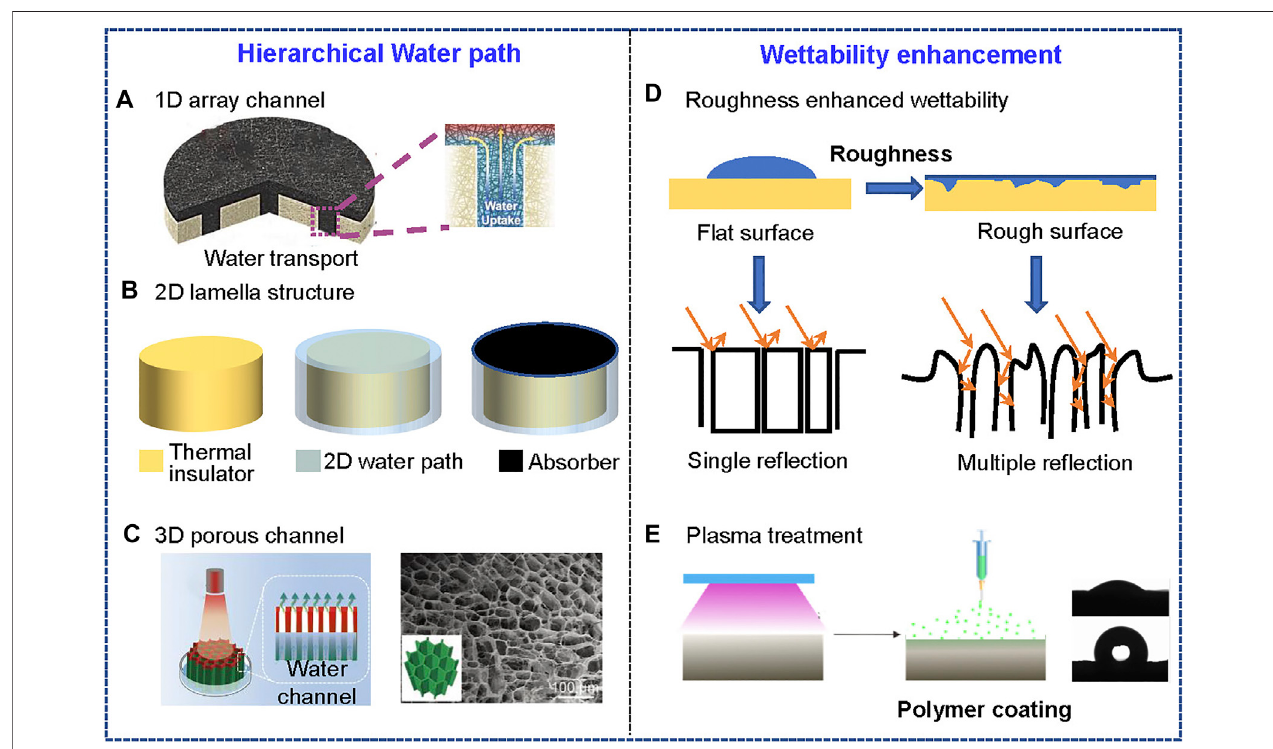
FIGURE 9 | Water management strategies for ef fi ciency enhancement of SVG. (A) Water supply which is delivered by 1D array channel with reduced contact aera to minimize conduction heat loss. Reprinted with permission from (Gao T. et al., 2019). Copyright (2019) WILEY VCH. (B) Water supply enabled by 2D lamella structure that is integrated with thermal insulator underneath the water path (Li et al., 2016). (C) Water supply provided by 3D porous channel that is directly soaking in water. Reprinted with permission from (Xiong et al., 2021). Copyright (2021) WILEY VCH. (D) (top) Enhanced wettability provided by rough surface (Drelich et al., 2011). (bottom) The light absorption is increased by multiple re fl ection on rough surface when compared to that of fl at surface (Qiu et al., 2019). (E) Plasma treatment for fi ber surface hydrophilicity modi fi cation. The water contact angle measurement exhibited thetreated surface and untreated surface withthe opposite wettability ontwo sides of aerogel. Reprinted with permission from (Li et al., 2020a). Copyright (2020) American Chemical Society.